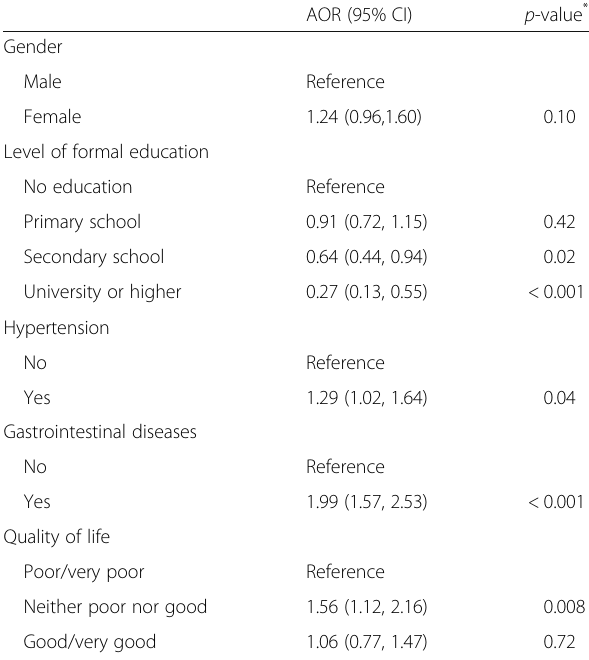
Table 3 Factors associated with herb use among patients with chronic diseases